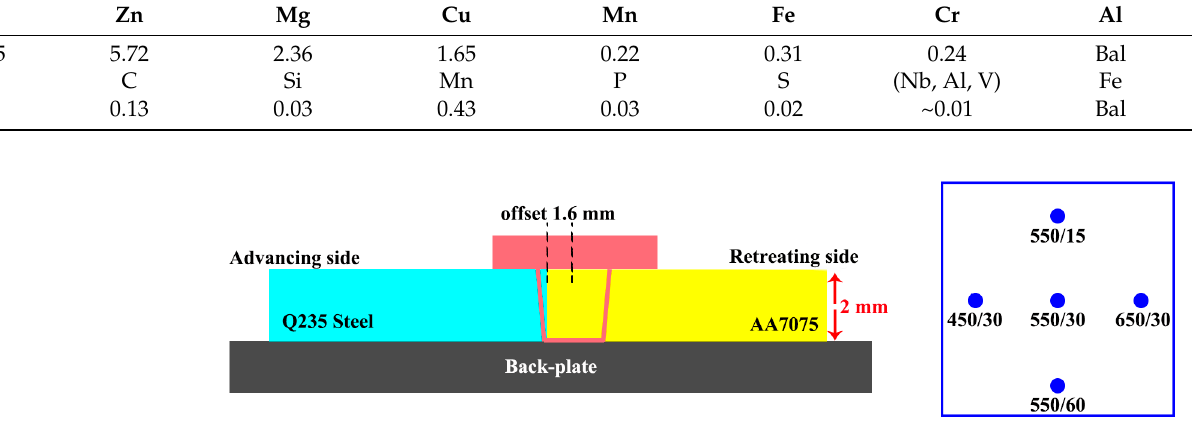
Figure 1. The FSW schematic diagram and the FSW parameters employed in this work.